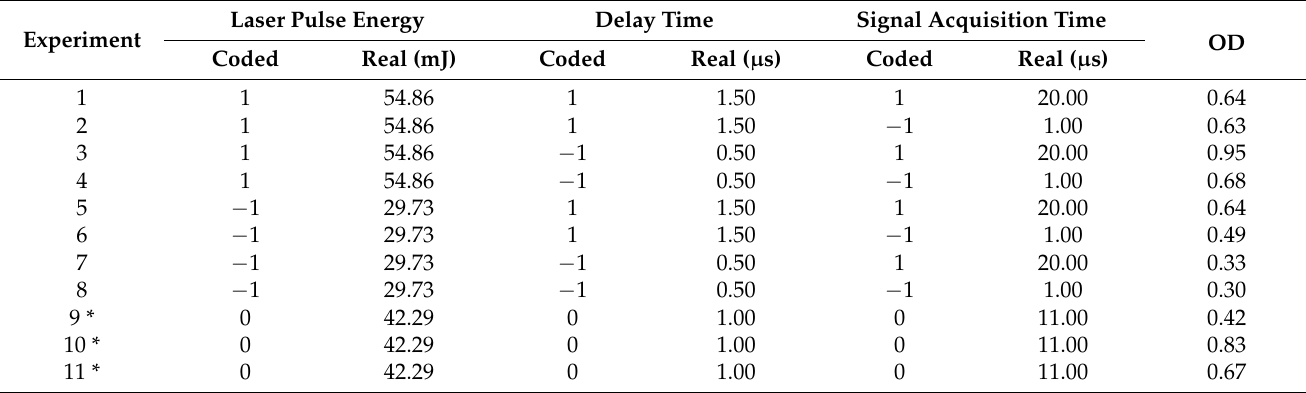
Table 2. Matrix of 2 3 factorial design with central point and variables evaluated for LIBS and results obtained from overall desirability